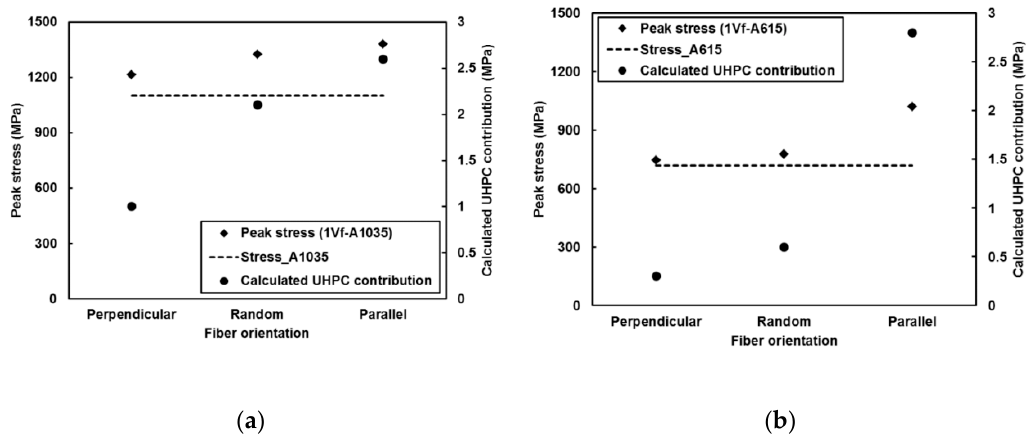
Figure 14. E ff ect of fiber orientation ( V f = 1%) on tensile behavior: ( a ) A1035 bars; ( b ) A615 bars.